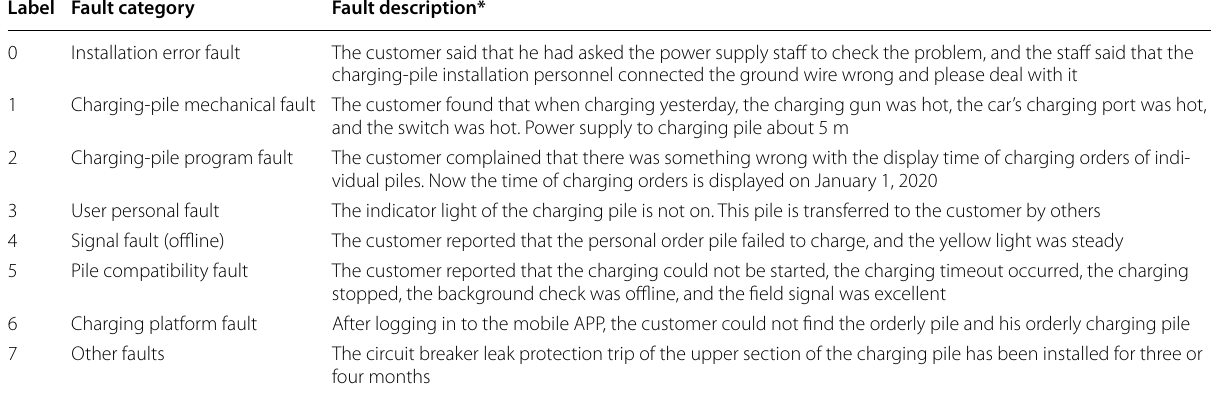
Table 2 Fault record